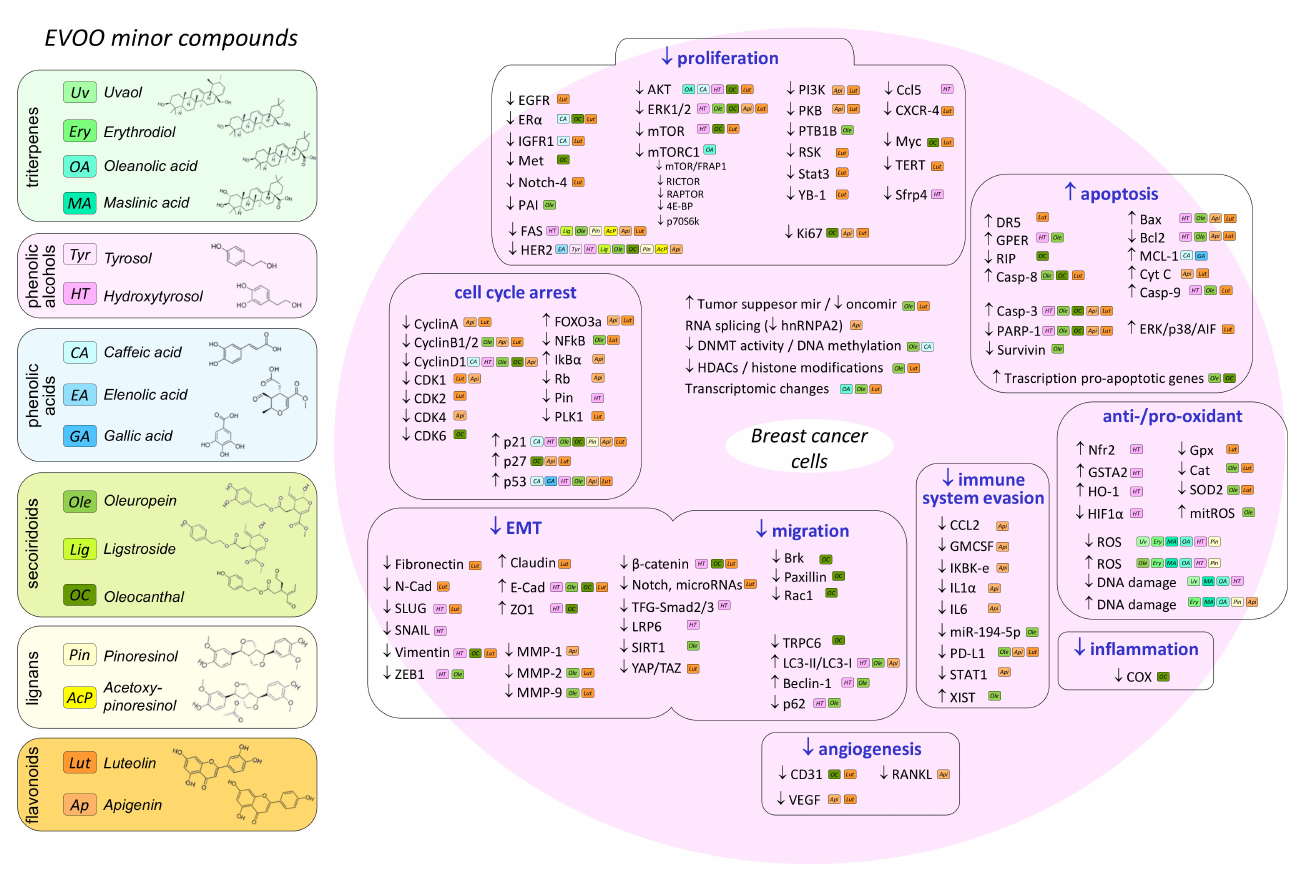
Figure 2. Molecular effects of EVOO minor compounds on mammary carcinogenesis. Compounds are grouped by chemical family and their effects in different molecular targets with a role in the acquisition of tumor hallmarks are indicated. General transcriptomic and epigenetic mechanisms are not associated with a specific hallmark. Many of the molecular targets shown have a role in different tumor hallmarks; in this figure, molecules are classified according to the main effects described in the specific bibliography. ↓ , decrease, downmodulation or inactivation; ↑ , increase, upmodulation or